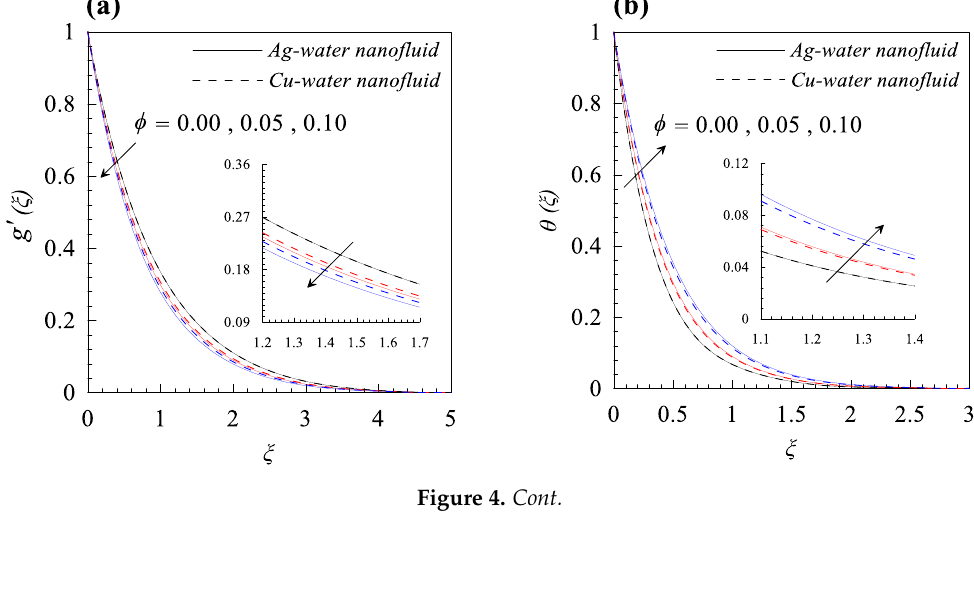
Figure 3. Effects of magnetic parameter M on ( a ) velocity profile g ’( ξ ), ( b ) temperature distribution θ ( ξ ), and ( c ) entropy generation Ns ( ξ ), when κ = 10, φ = 0.01, ε = 0.2, Ec = 0.3, and λ = 0.5.